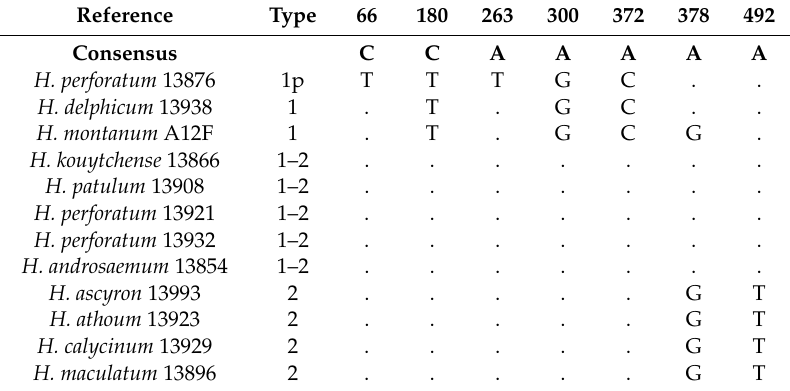
Table 4. Haplotype map of the rbc L region, assigning reference samples to haplotype. Type 1–2 represents an intermediate haplotype between types 1 and 2. Dots indicate identity with the consensus base at that